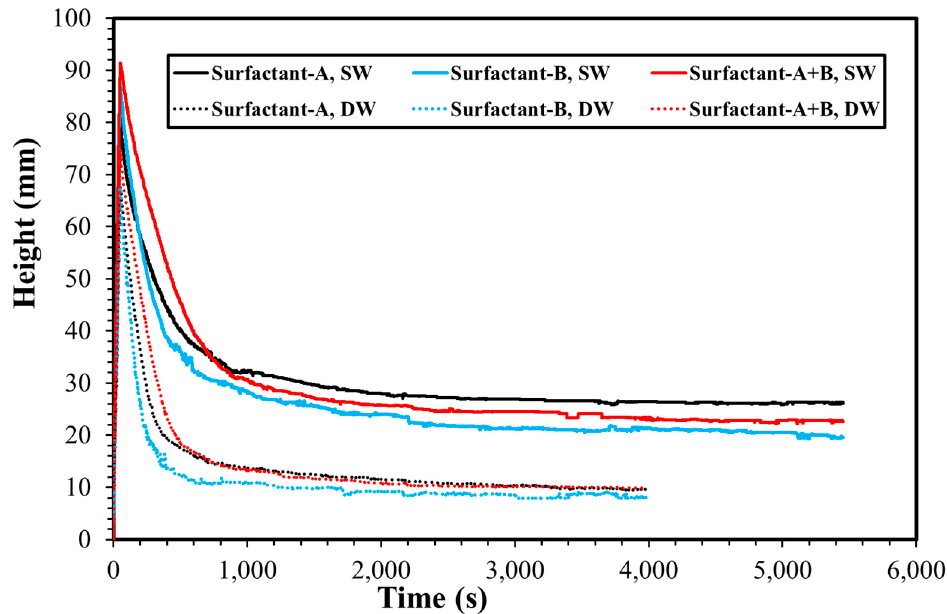
Figure 5. Foamability of different surfactant systems in seawater and deionized water using CO 2 injection at 25 °C.